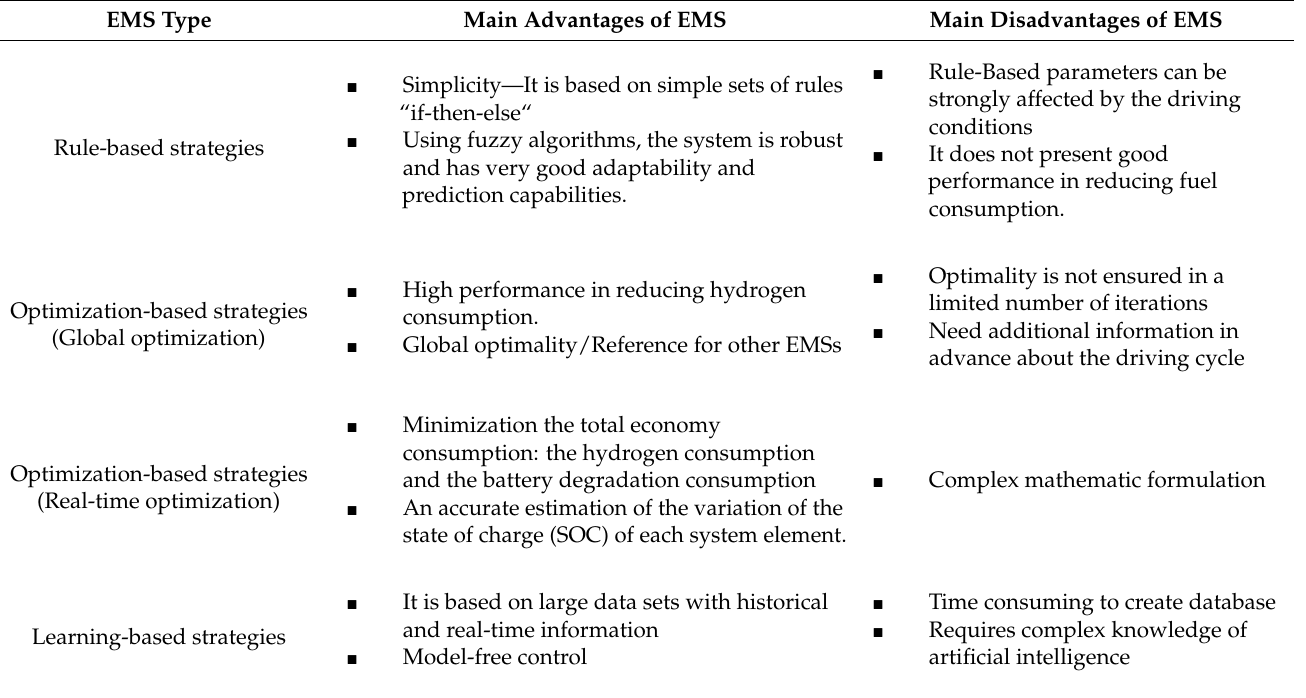
Table 3. The main advantages and disadvantages of Energy Management Strategies (EMS) EMS Type Main Advantages of EMS Main Disadvantages of